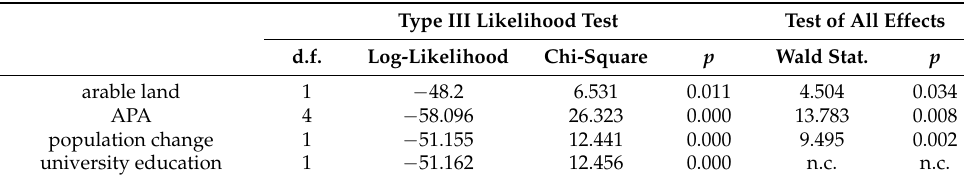
(Hosmer–Lemeshow = 8.019, p = 0.432; Cox-Snell pseudo R 2 = 0.498).